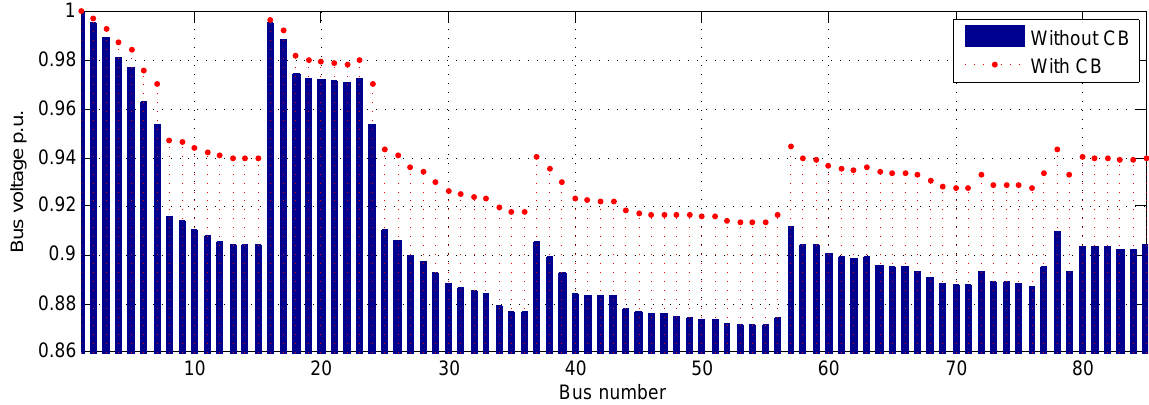
Figure 9. Box plot of 50 runs, 85-bus system (the median is represented in the central mark, and the ’+’ symbol denotes the outliers).